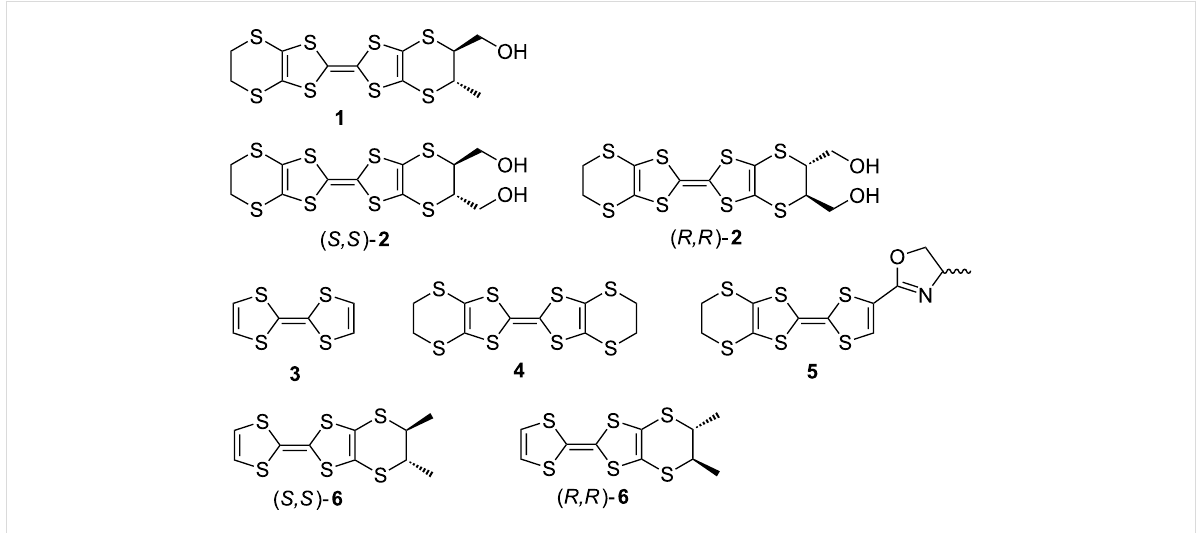
Figure 1: Molecular structures of trans-vic- (hydroxymethyl)(methyl)-BEDT-TTF ( 1 ), trans-vic- bis(hydroxymethyl)-BEDT-TTF ( 2 ), TTF ( 3 ), BEDT-TTF ( 4 ), EDT-TTF-methyl-oxazoline 5 , and trans- dimethyl-EDT-TTF ( 6